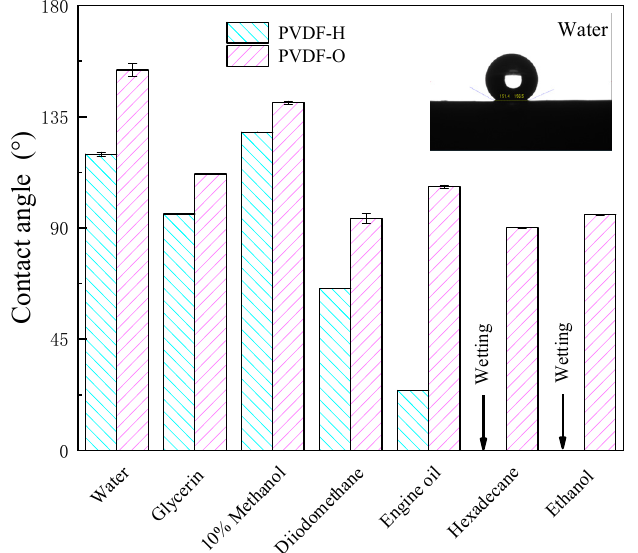
Figure 5. Contact angles of different liquids on the surface of PVDF-H and PVDF-O membrane.